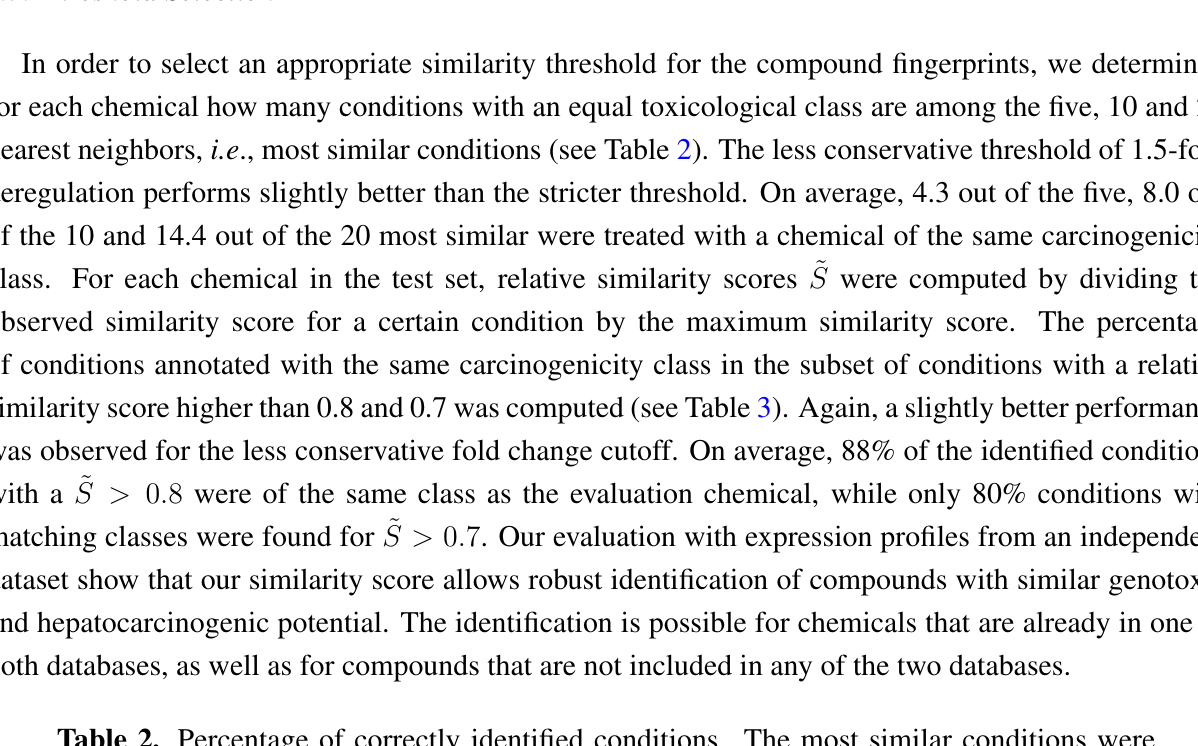
Table 2. Percentage of correctly identified conditions. The most similar conditions were extracted for each chemical in the evaluation set. The percentage of conditions with the same carcinogenicity class in the five, 10 and 20 most similar conditions was